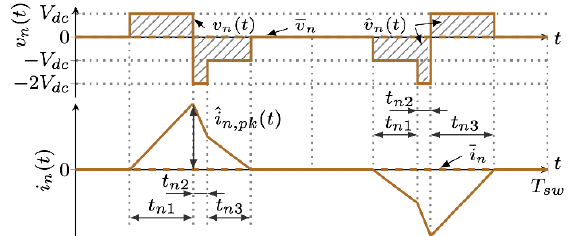
Figure 28. Neutral current ripple waveform ( bottom ) and equivalent neutral voltage pulse disposition ( top ) in one switching period.